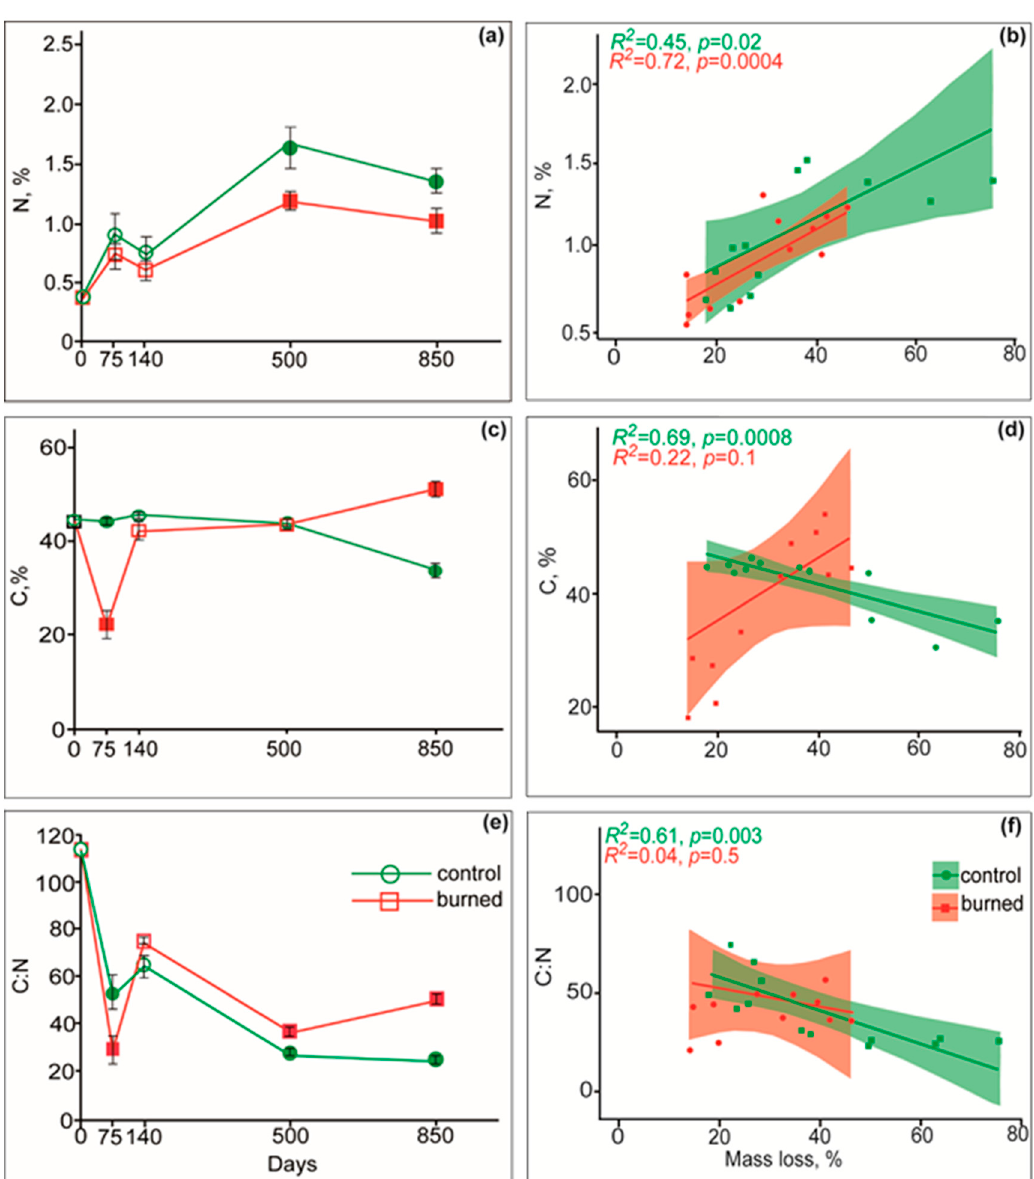
Figure 4. Dynamics of nutrient concentrations ( a , c , e ) and linear relationship between the mass loss and concentrations of C ( b ) and N ( d ) and the C:N ratio ( f ) in the control and burned stands. Error bars represent ±SE ( n = 6). Filled markers denote significant differences ( p < 0.05 based on ANOVA followed by Tukey HSD). Red and green areas represent the 95% confidence intervals in the burned and control stands, respectively.